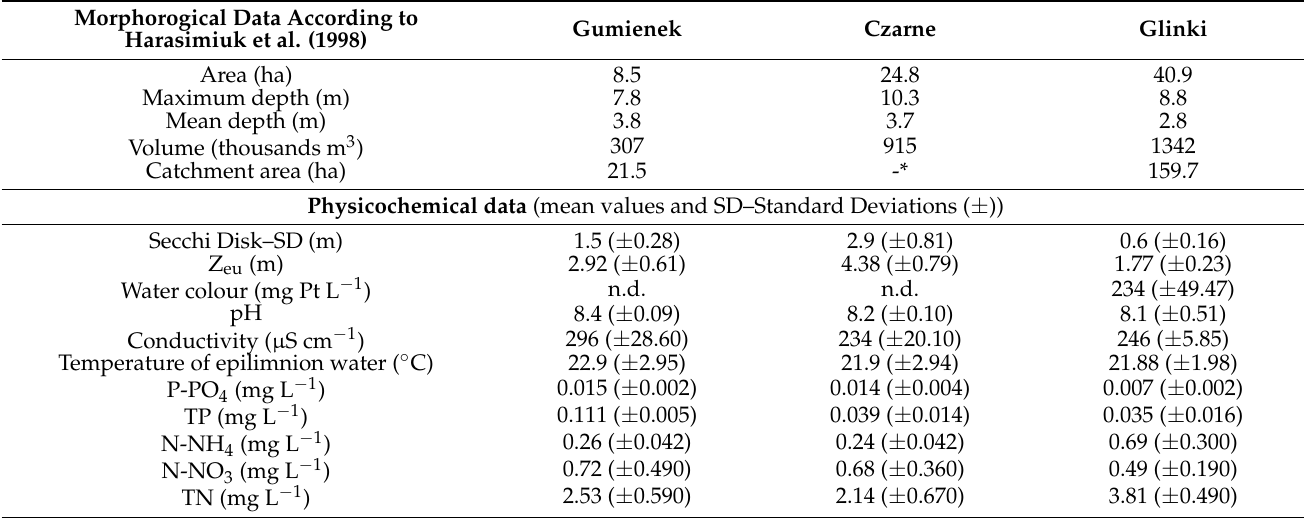
Table 1. Morphological, physicochemical, and biological data of the studied